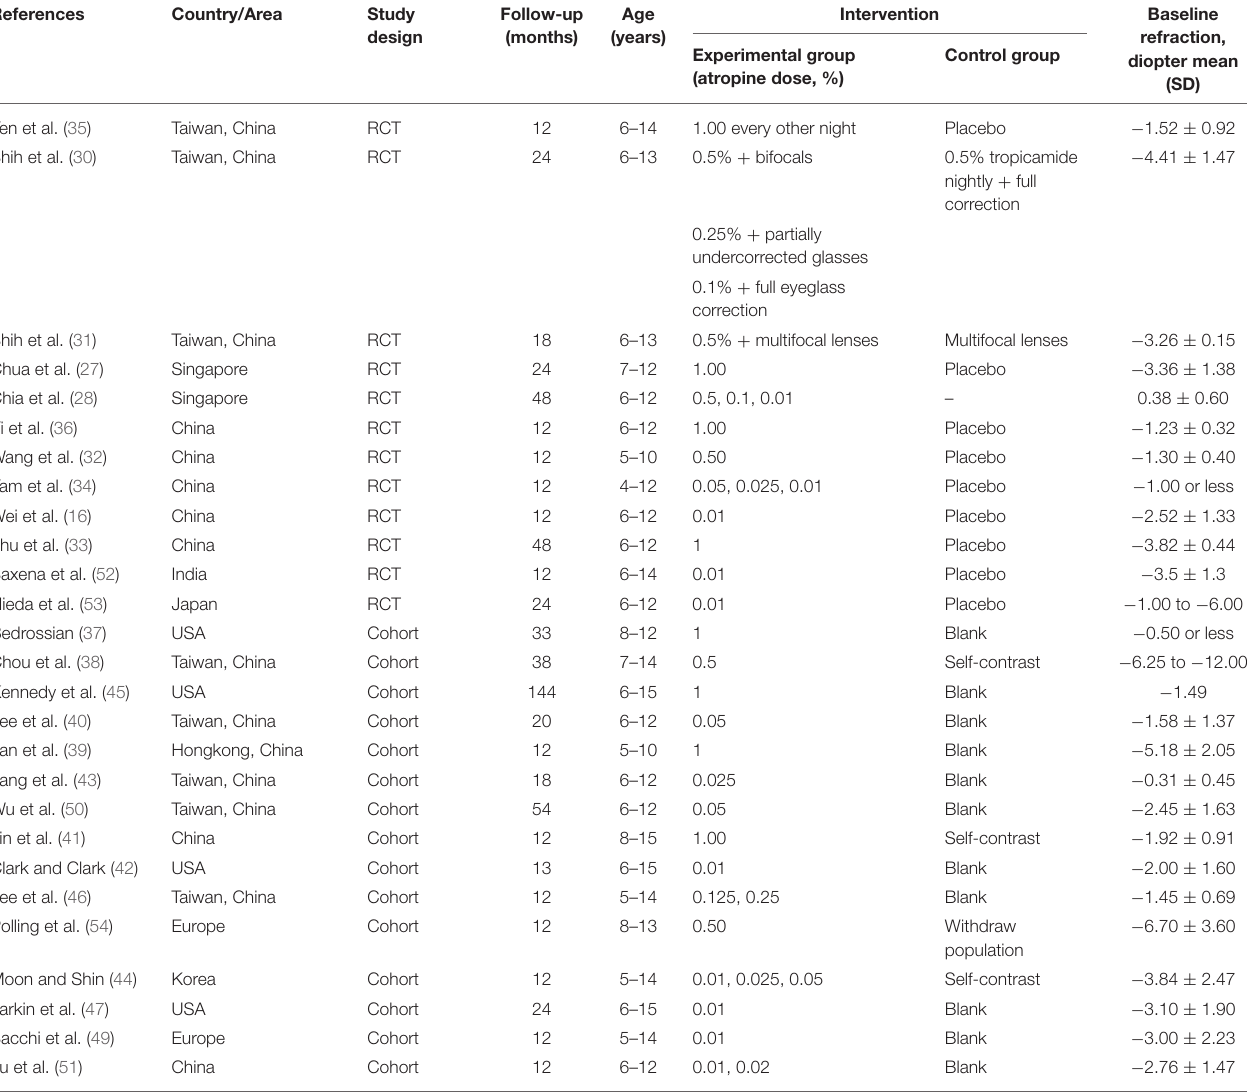
TABLE 1 | Characteristics of the studies included in the